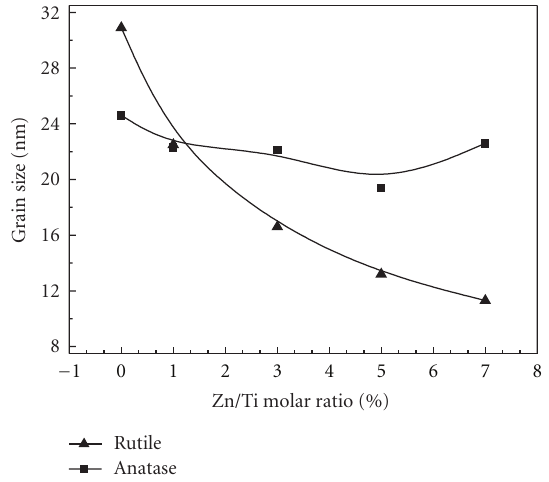
Figure 2: Variation of grain sizes of anatase and rutile TiO 2 in ZT series samples.